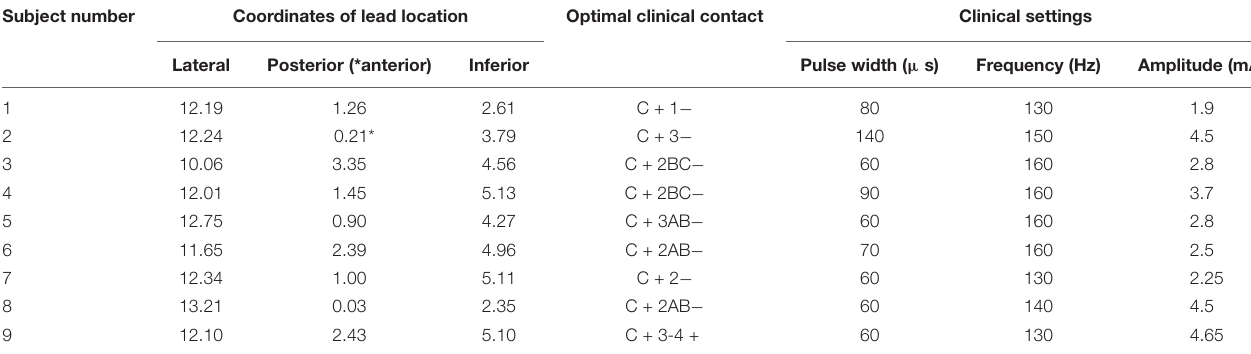
TABLE 2 | Lead location and programming